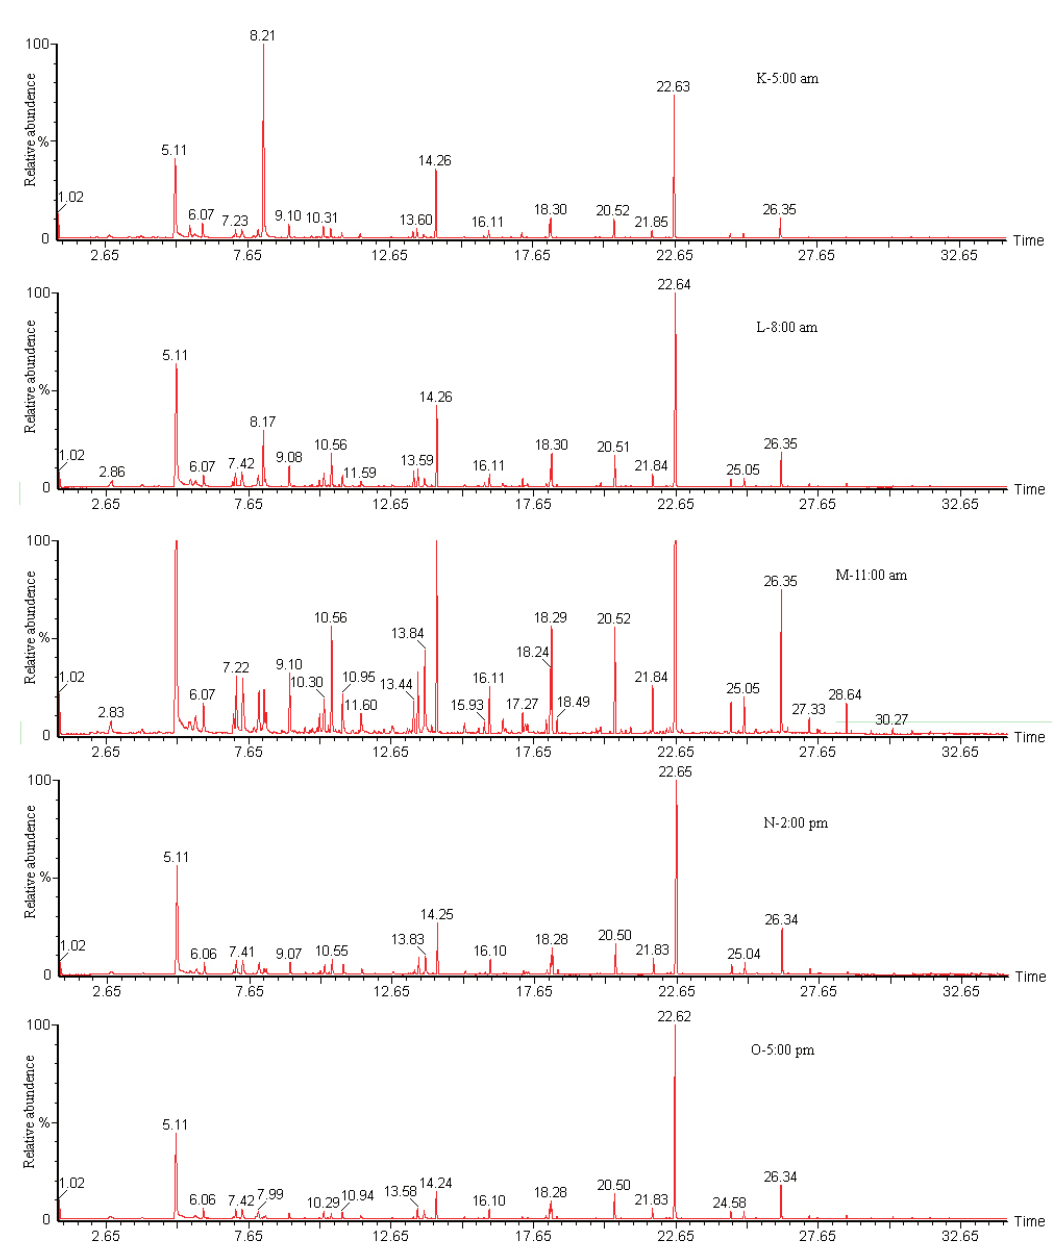
Fig. 3: GC/MS total ion current chromatograms of volatile compounds from four seasons rose in sunny